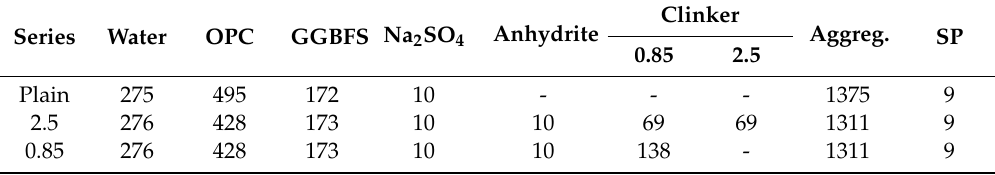
Table 3. Mix proportions of concrete (in kg/m 3 ).